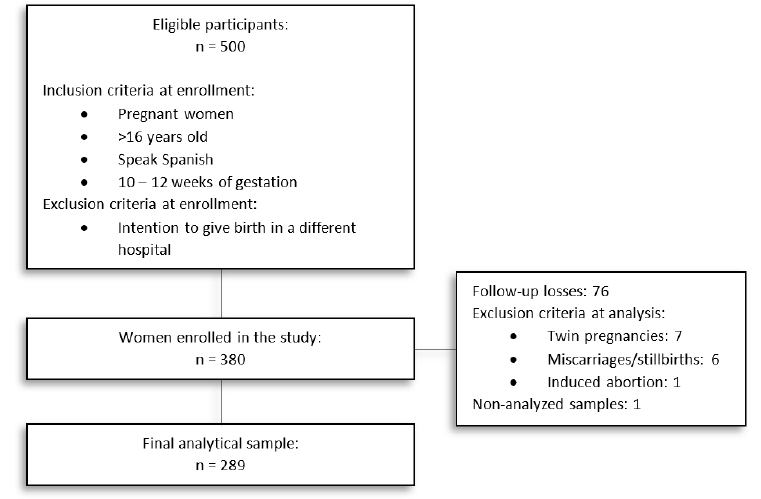
Figure 1. Flow diagram of participants.